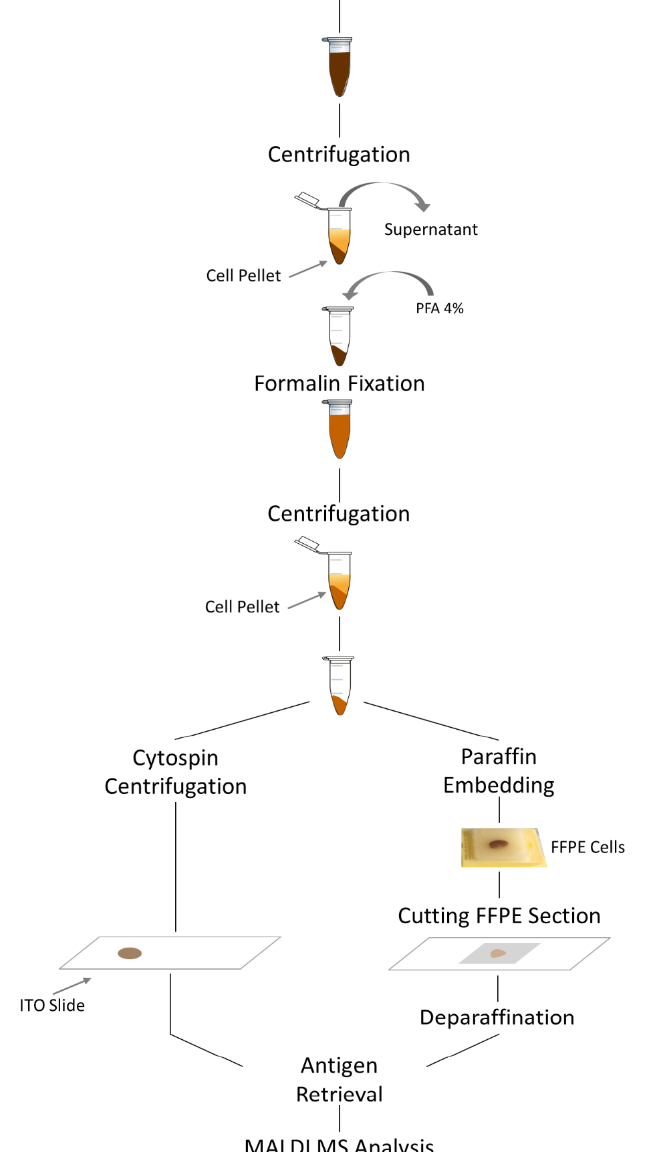
Figure 1. Representative workflow for formalin-fixed cell processing. Cell suspension was transferred to a centrifuge tube and concentrated by centrifugation for 10 min at 800 RCF. The cell pellet was resuspended with 4% paraformaldehyde and stored for approximately two weeks. Formalin-fixed cell suspension was centrifuged, and the paraformaldehyde was removed. One third of the cell pellet was resuspended in 70% ethanol, from which 150 µL was cytocentrifuged onto indium-tin oxide-coated (ITO) glass slides. The remaining cell pellet was processed to create a paraffin-embedded block. Then, 3 µm FFPE sections were mounted onto the ITO slide, dewaxed, and antigen retrieved together with the cytocentrifuged cells using heat-induced epitope retrieval combined with trypsin enzyme digestion. MALDI MS analysis was performed.